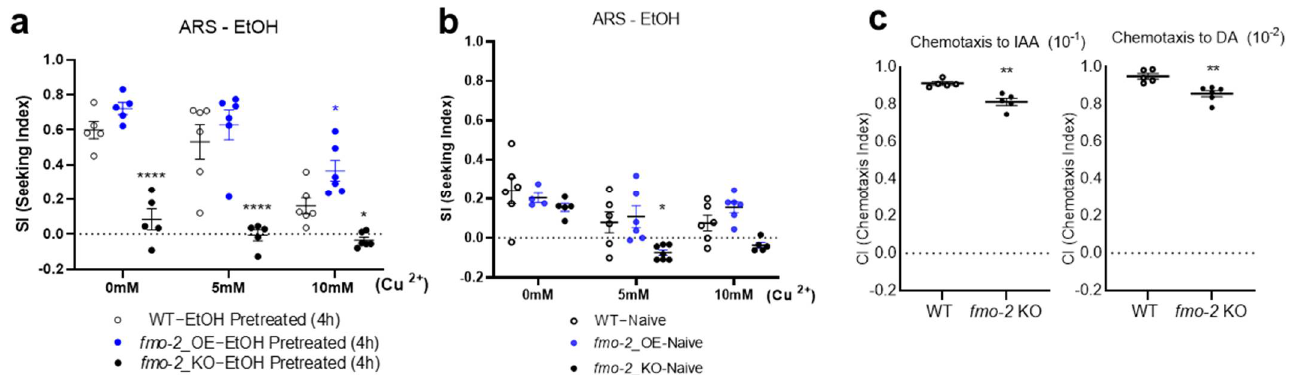
Figure 5. FMO-2 functions in modulation of ethanol preference and ARS. ( a ) fmo-2 -overexpressing animals that were pretreated with ethanol for 4 h surmounted a stronger aversive barrier for ethanol. More fmo-2 -overexpressing animals crossed over the barrier for ethanol (demonstrating ARS) than did the WT animals. The fmo-2 KO animals showed impaired ethanol preference and ARS. Strength of ethanol seeking was represented by SIs under different concentrations of the copper barrier (no barrier, 5 mM, and 10 mM). A two-way ANOVA comparison of the strains over different barrier concentrations showed significant differences based on genotype, concentration, and the interaction of the two. [FGenotype (2, 41) = 65.25, p < 0.0001; FConcentration (2, 41) = 19.98, p < 0.0001; FGenotype × Concentration (4, 41) = 2.668, p = 0.0456]. Significant post hoc differences (multiple comparison correction using Dunnett’s method) between strains in each condition (no barrier, 5 mM, or 10 mM) are shown ( p < 0.05, *; p < 0.0001, ****). Each dot represents an assay that used a population of 100–150. ( b ) Naïve animals were used as controls in the ARS assay. A two-way ANOVA comparison of the strains over different barrier concentrations showed no significant differences based on the interaction of genotype and concentration. [FGenotype × Concentration (4, 26) = 1.328, p = 0.2858]. Significant post hoc differences (multiple comparison correction using Dunnett’s method) were only observed between the fmo-2 KO and the WT animals at a 5 mM barrier. p < 0.05, *. ( c )